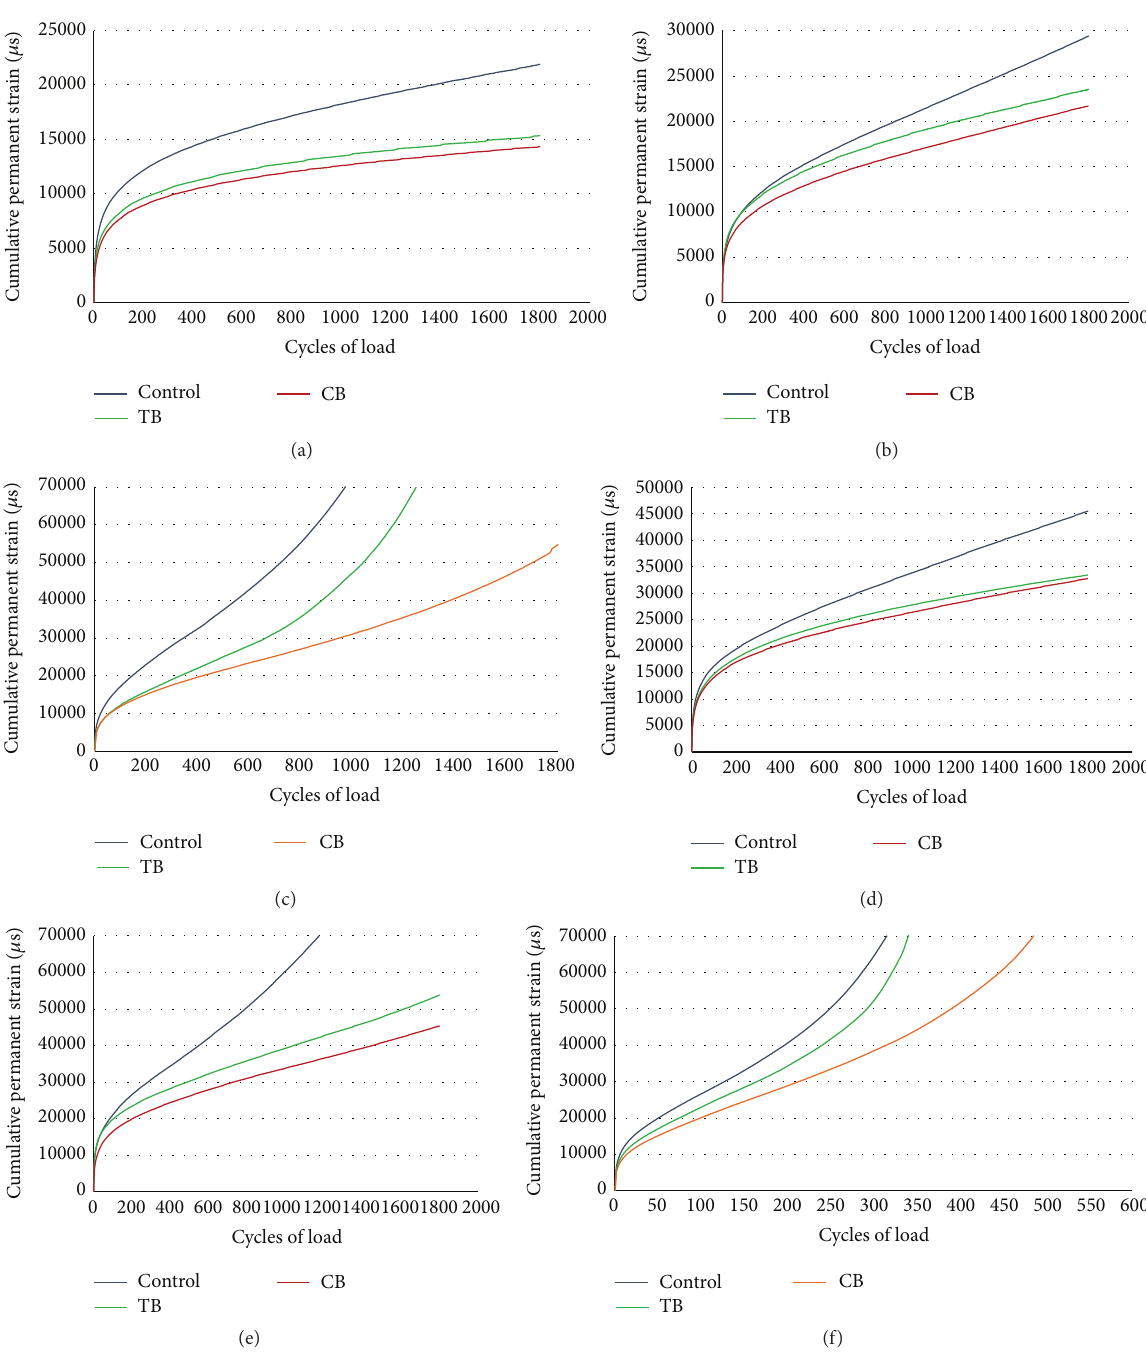
Figure 4: (a) Cumulative permanent strain versus load cycle for control and rubberized asphalt mixtures tested at 200 kPa at 40 ∘ C. (b) Cumulative permanent strain versus load cycle for control and rubberized asphalt mixtures tested at 200 kPa at 50 ∘ C. (c) Cumulative permanent strain versus load cycle for control and rubberized asphalt mixtures tested at 200 kPa at 60 ∘ C. (d) Cumulative permanent strain versus load cycle for control and rubberized asphalt mixtures tested at 400 kPa at 40 ∘ C. (e) Cumulative permanent strain versus load cycle for control and rubberized asphalt mixtures tested at 400 kPa at 50 ∘ C. (f) Cumulative permanent strain versus load cycle for control and rubberized asphalt mixtures tested at 400 kPa at 60 ∘